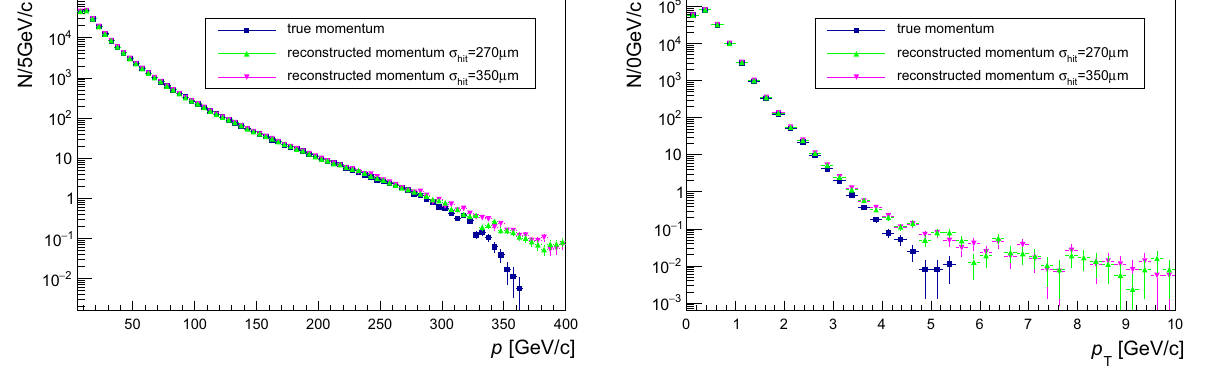
Fig. 4 EffectofadditionalGaussiansmearingonthemomentumdistri- butioninthesimulation,left p ,right p T .Thedistributionscorrespondto the simulation truth before reconstruction (navy blue), the nominal